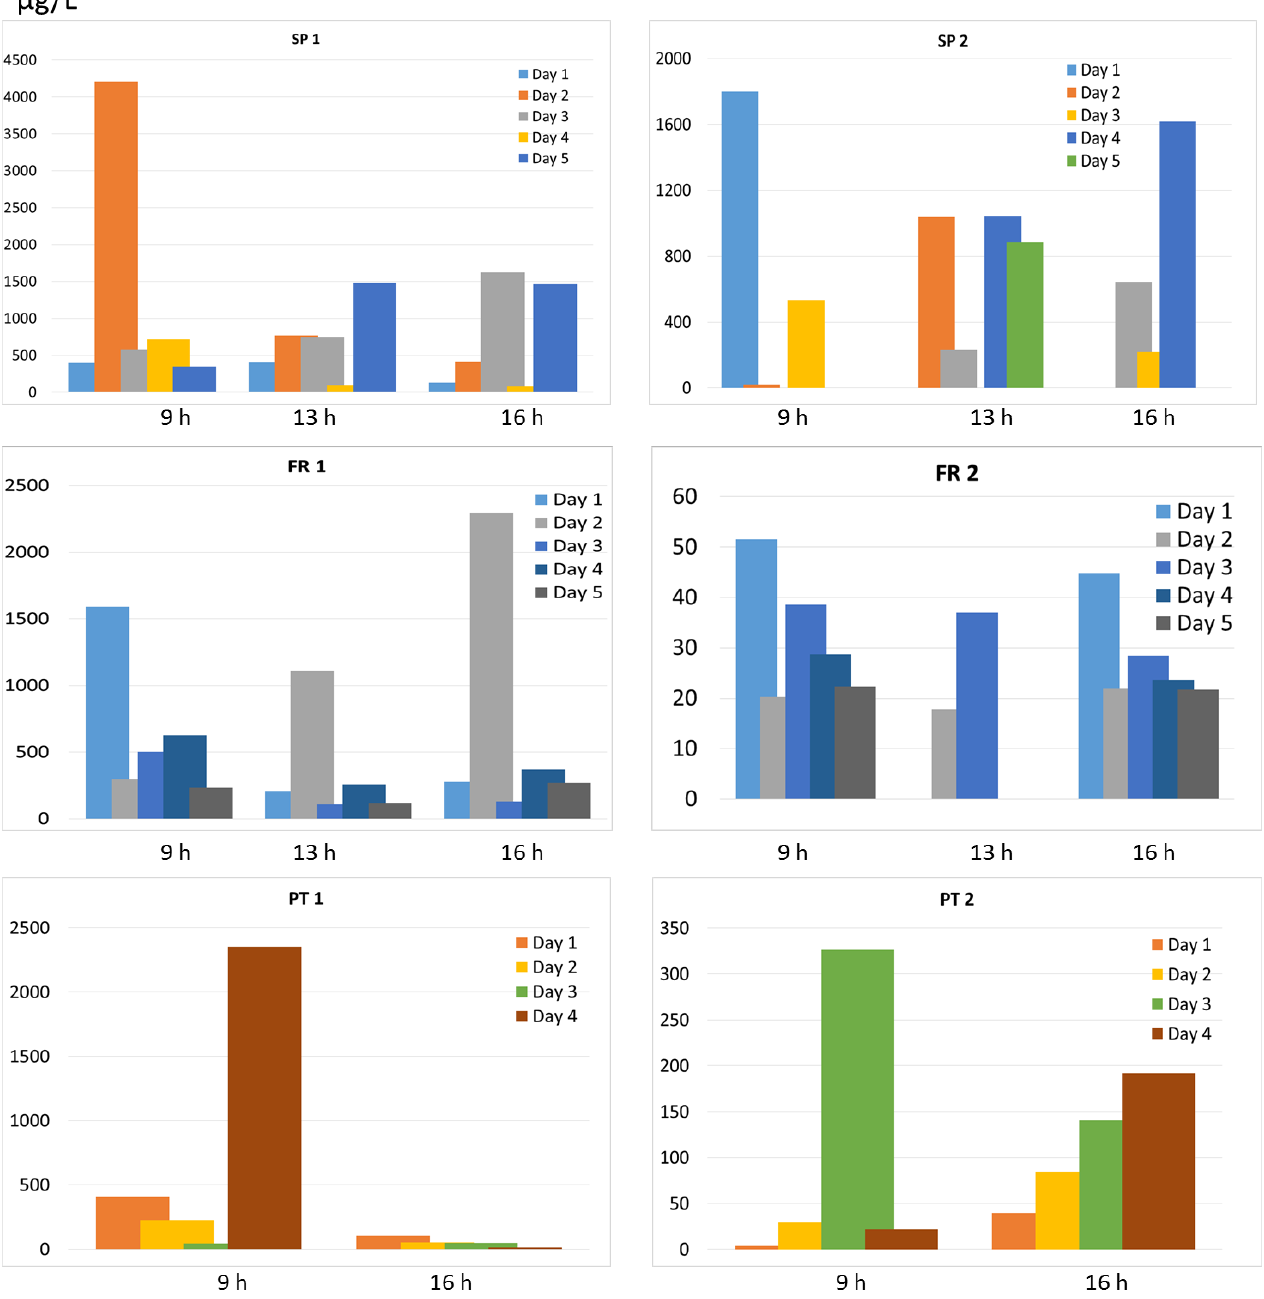
Figure 1. Total pharmaceuticals detected in water ( µ g L − 1 ) in each sampling day within one week and at the different time frames (morning and afternoon flushes) in senior residences from Spain (SP 1 and SP 2), France (FR 1 and FR 2) and Portugal (PT 1 and PT 2).